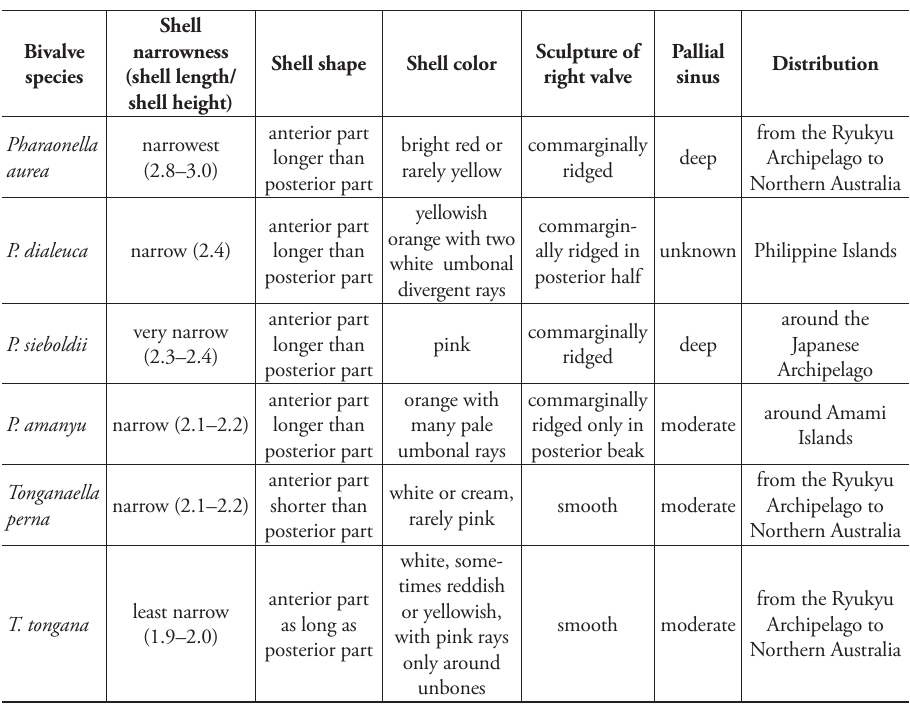
Table 2. Morphological characters of Tonganaella and Pharaonella